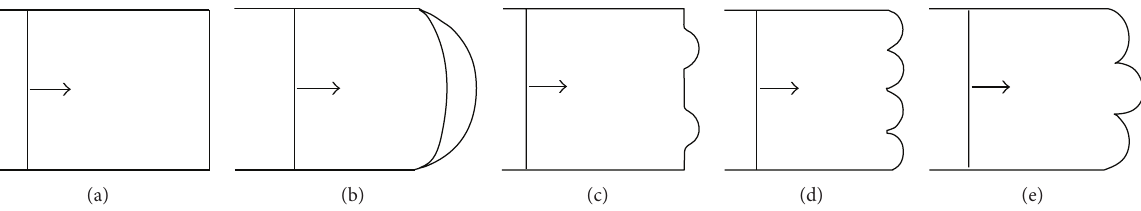
Figure 19: The typical forms of concave surfaces for optimization of initiation at SW reflection: (a) plane reflector; (b) single ring or elliptical reflector on whole cross-section or single ring or elliptical reflector on limited part of cross-section; (c) two ring or elliptical reflectors shifted one another; (d) some neighboring elliptical reflectors located along plane; (e) some ring or elliptical reflectors located along concave elliptical line (neighboring or with shift).